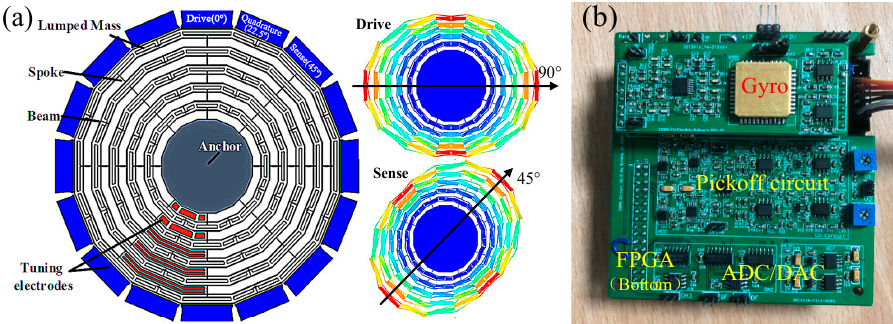
Figure 7. ( a ) Structure of the CDRG and the ( b ) control circuit.